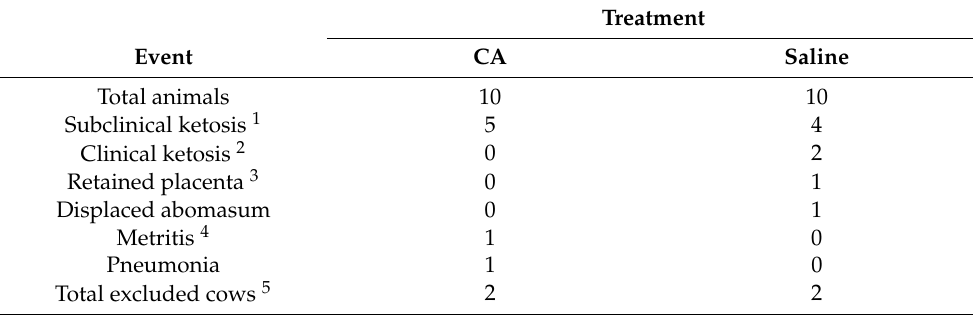
Table 1. Frequency of occurrence of health problems in peripartum dairy cows receiving an intra- venous infusion of carnosic acid (CA) or saline (Saline) from − 21 relative to parturition through 21 DIM. Treatment CA